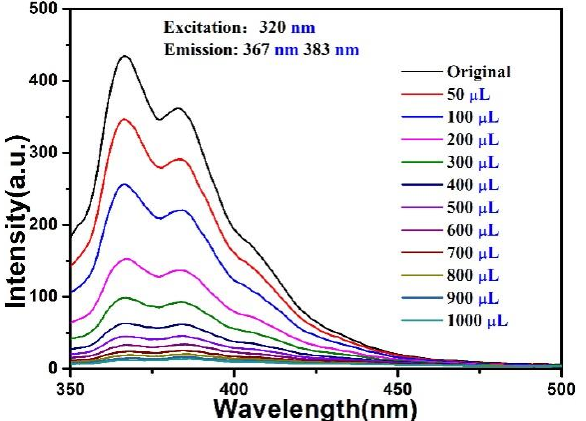
Figure 9. Fluorescence spectra of the compound towards trinitrophenol (5 × 10 − 4 M).